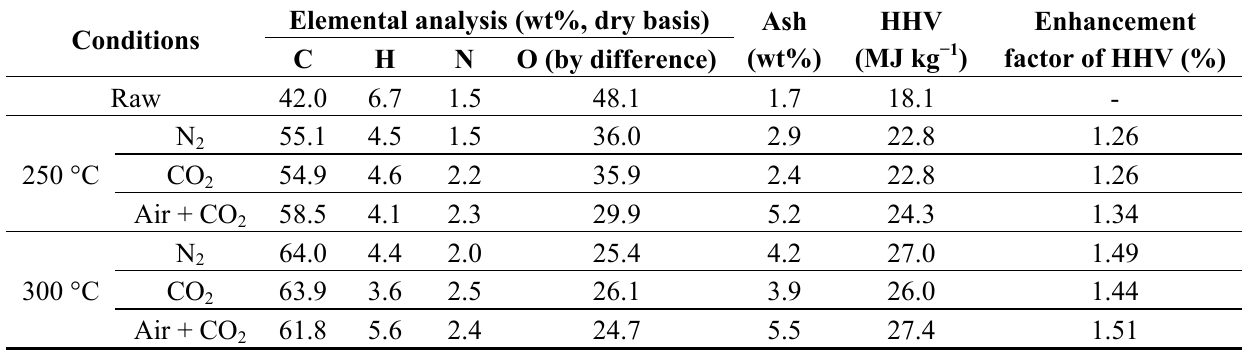
Table 2. Elemental analyses, ash contents, and calorific values of raw and torrefied corncob